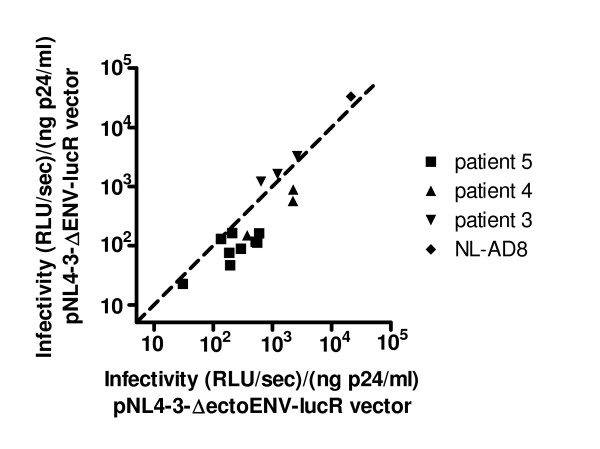
The effect of the origin of the intracellular portion of gp41 on infectivity. For selected clonal viruses isolated from patient 3 (inverted triangles), patient 4 (triangles), patient 5 (squares) or from the laboratory-adapted strain NL-AD8 (diamond), two types of recombinant reporter viruses were generated, one in which gp120 + only the extracellular domain of gp41 was derived from the clonal virus (pNL4-3-ΔectoENV-lucR, abscissa), and one in which gp120 and all of gp41 was derived from the clonal virus (pNL4-3-ΔENV-lucR vector, ordinate). The ability of these viruses to infect U373-R5 cells was compared by evaluating luciferase expression in the target cells 44 hours after infection. The infectivity of each pair of viruses was evaluated in three independent experiments, and each symbol represents the mean of these determinations. The dotted line is the line of identity. The correlation coefficient (Spearman) for the data shown is 0.86 (p < 0.0001).